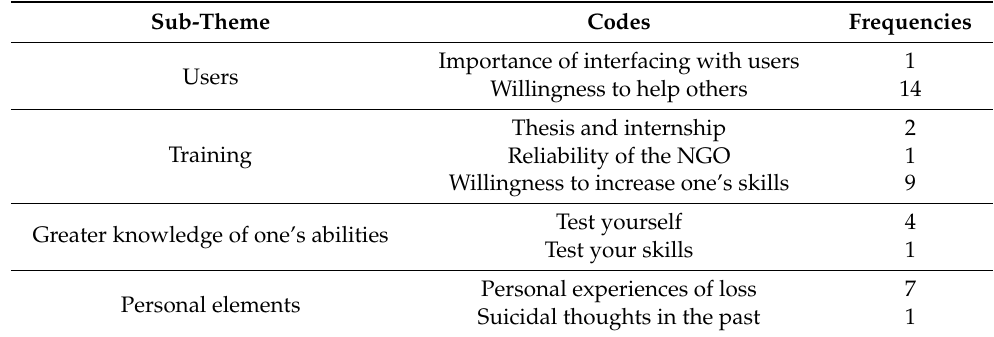
Table 3. Theme 1: “Motivation and Expectations”, sub-themes, codes emerged and related frequencies.